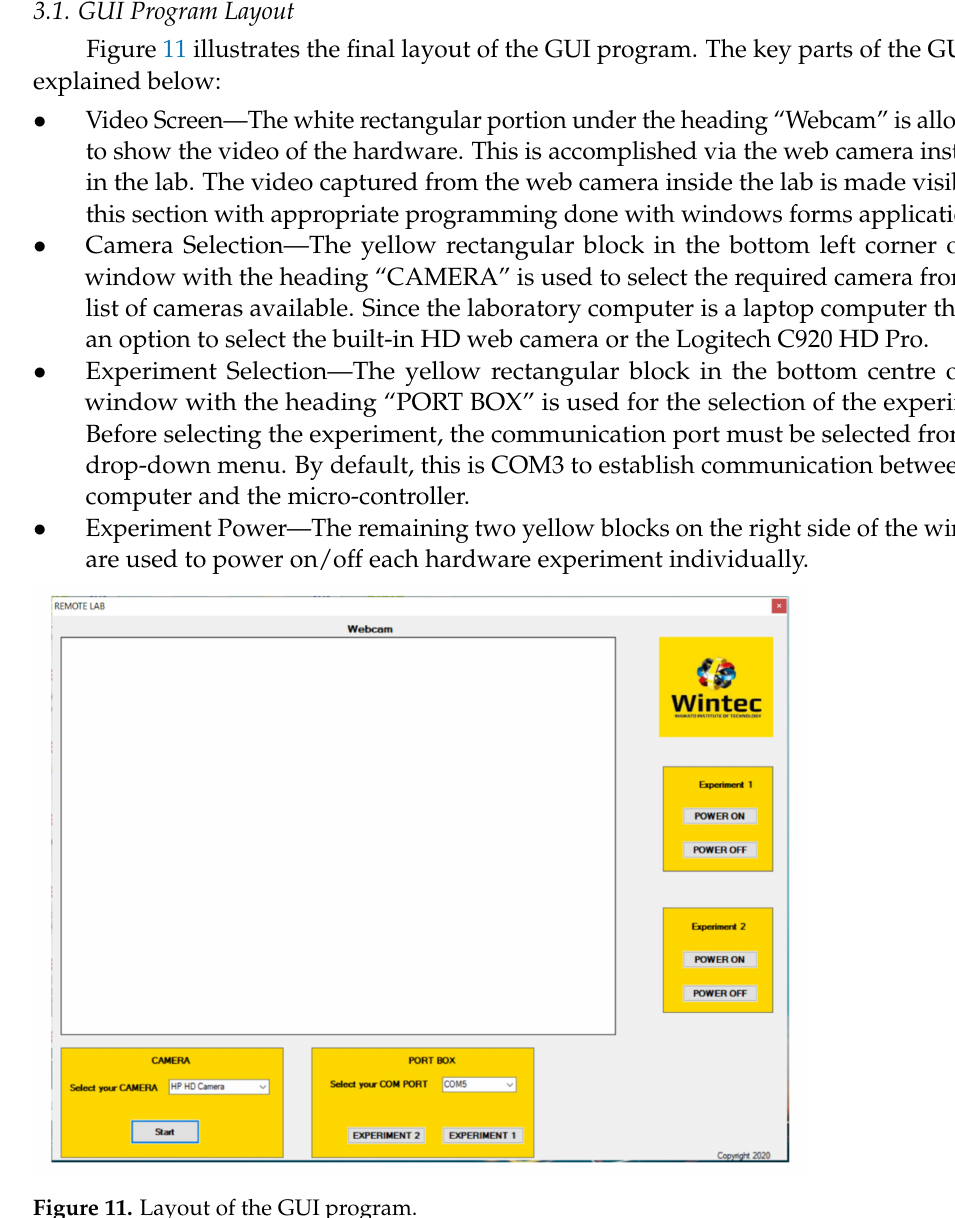
Figure 11. Layout of the GUI